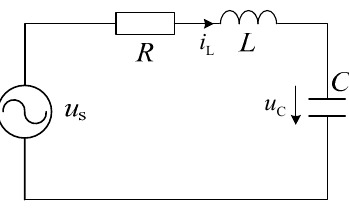
Figure 1. RLC series circuit.